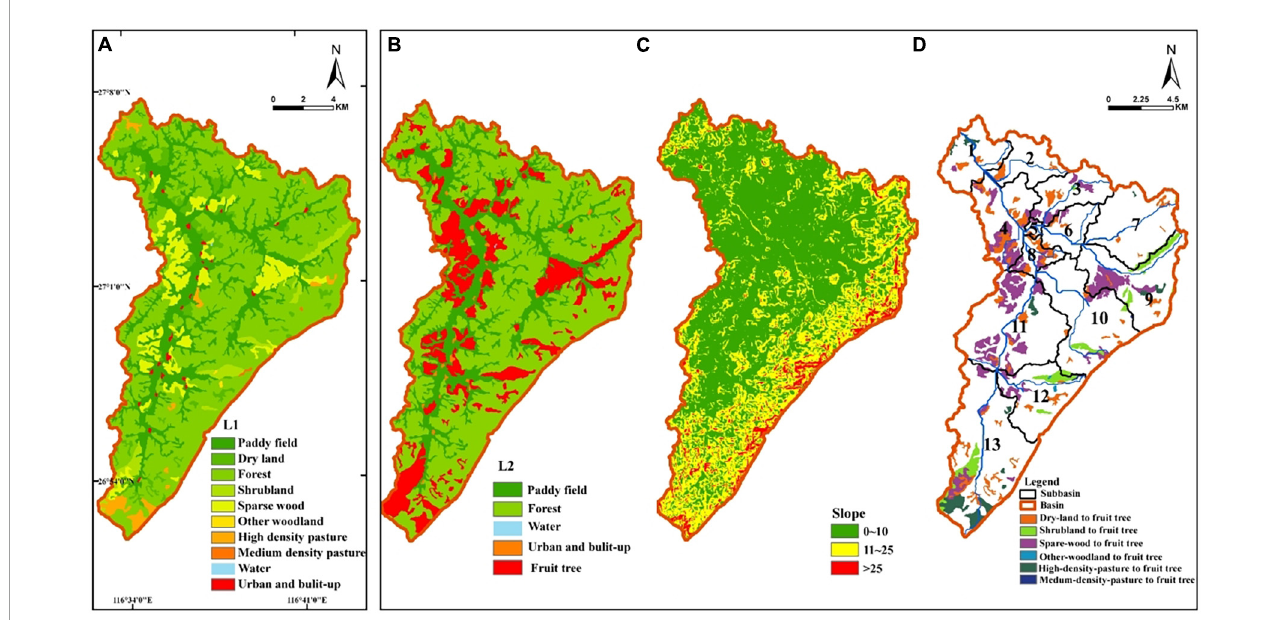
FIGURE4 (A) Baseline period, (B) land use during fruit tree expansion, (C) slope of the study area, (D) land use transfer from baseline to fruit tree expansion.